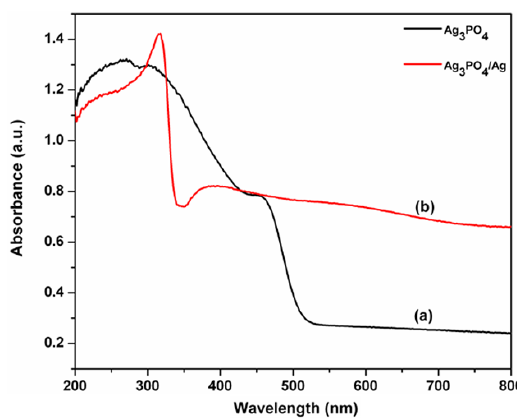
Figure 4. UV-vis absorption spectrum of (a) Ag and (b) Ag